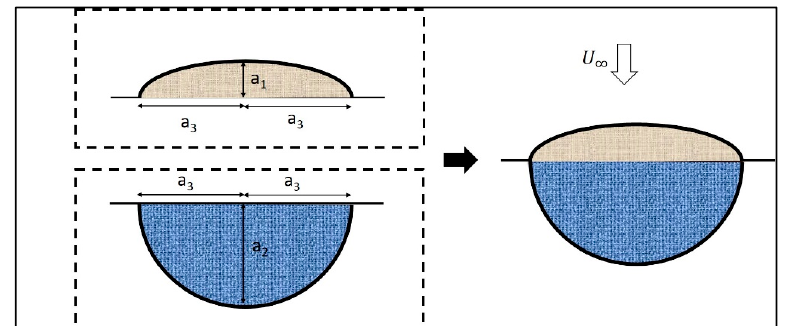
Figure 2. Zimmerman wing type.